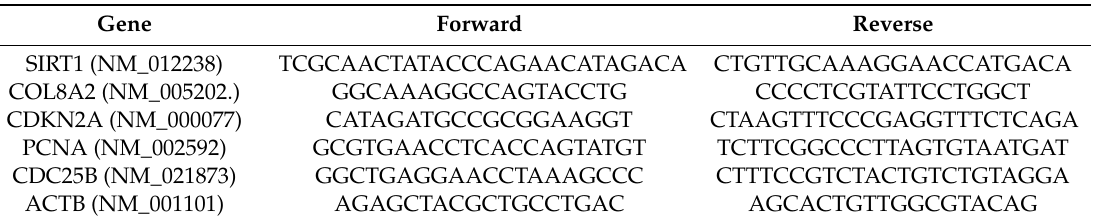
Table 1. Primer sequence for